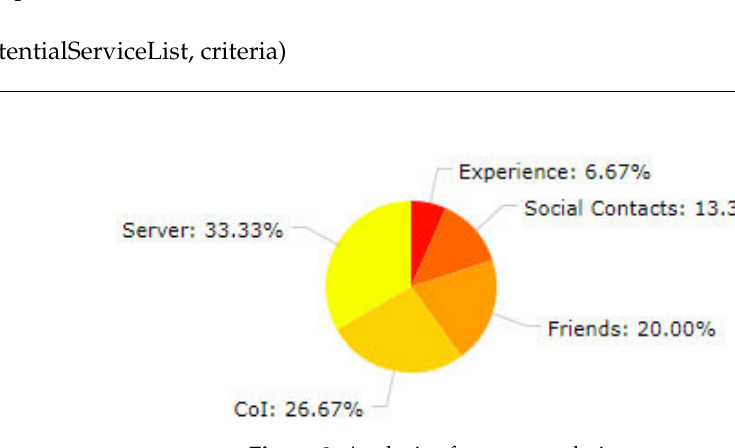
Figure 8. Analysis of